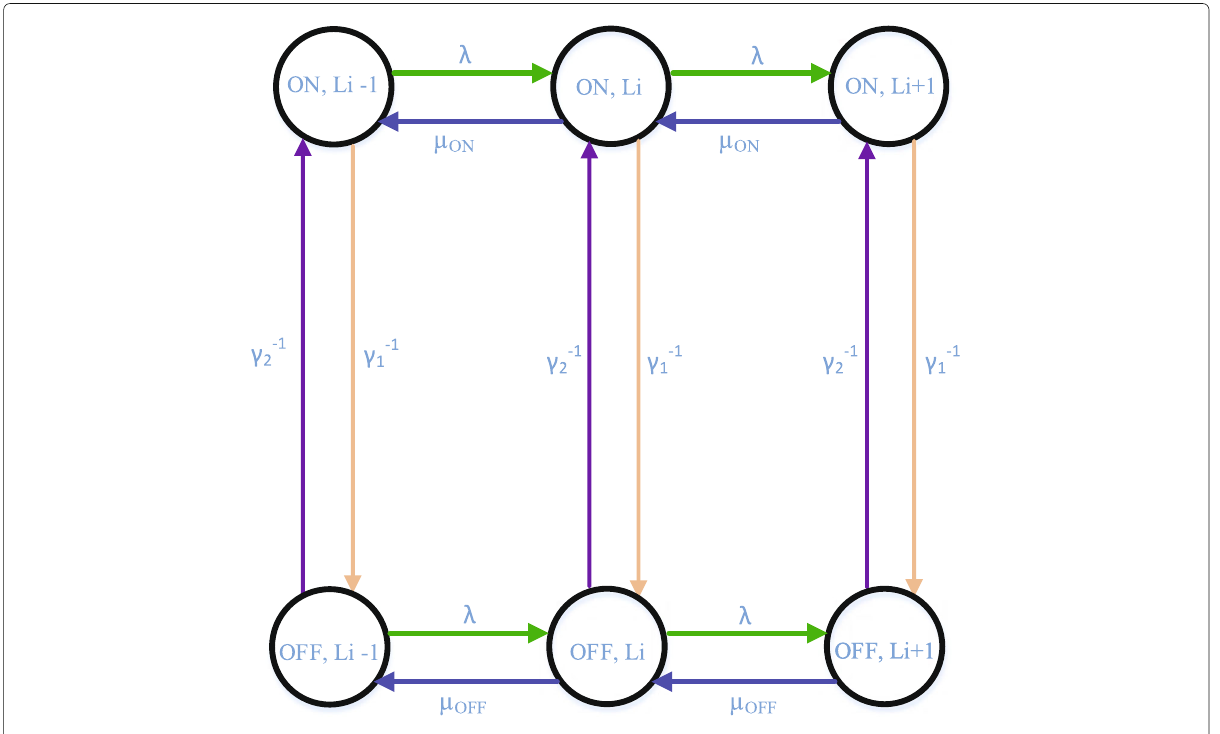
Fig. 2 Illustration of the transition rates for 0 < l i < L